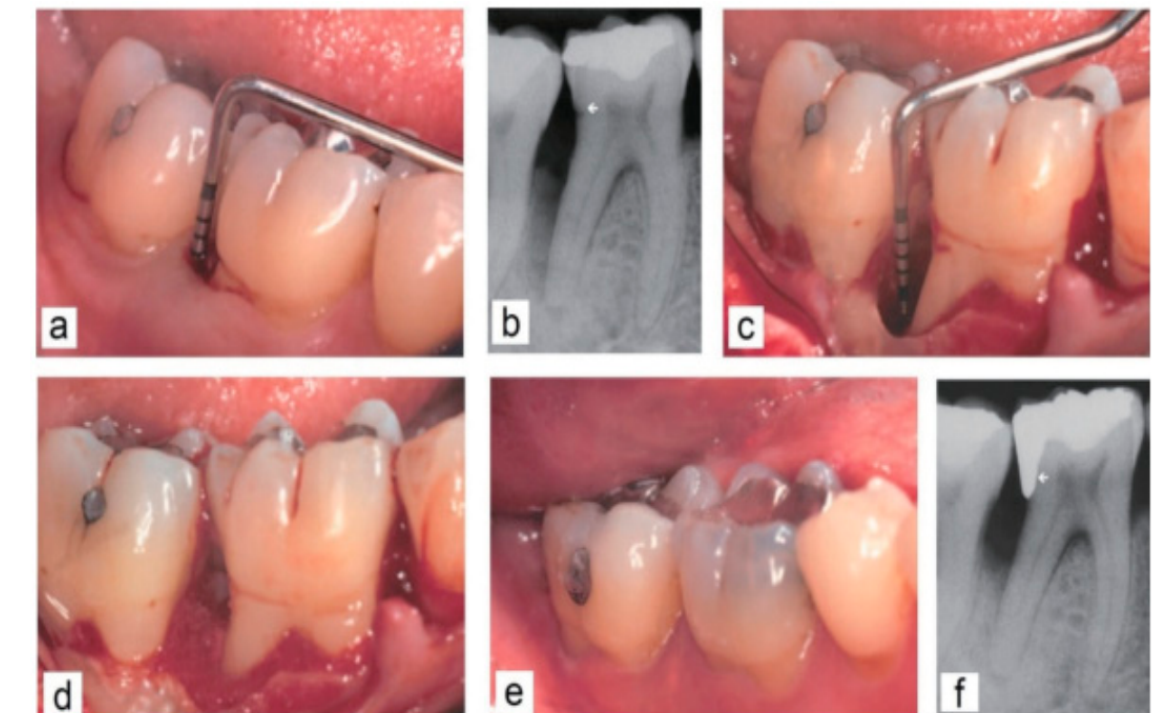
Figure 5. Clinical application of BG in a patient with generalized aggressive periodontitis. ( a , b ) Intra-bony defect prior to surgery. The arrow sign on the radiograph indicates distal cervical caries and the location of the cemento-enamel junction as a landmark. ( c , d ) Intraoperative situation after exposure of the defect. ( e , f ) Clinical and radiological situation 12 months after surgery. Moreover, the distal cervical caries was treated with a new filling